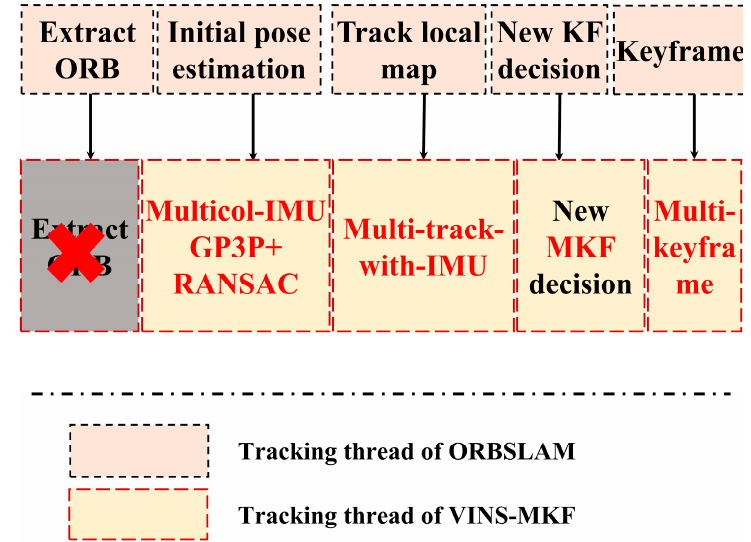
Figure 6. The comparison between the tracking procedure of VINS-MKF and ORBSLAM. The procedure of our proposed VINS-MKF is similar to ORBSLAM, while several adjustments were adopted in the